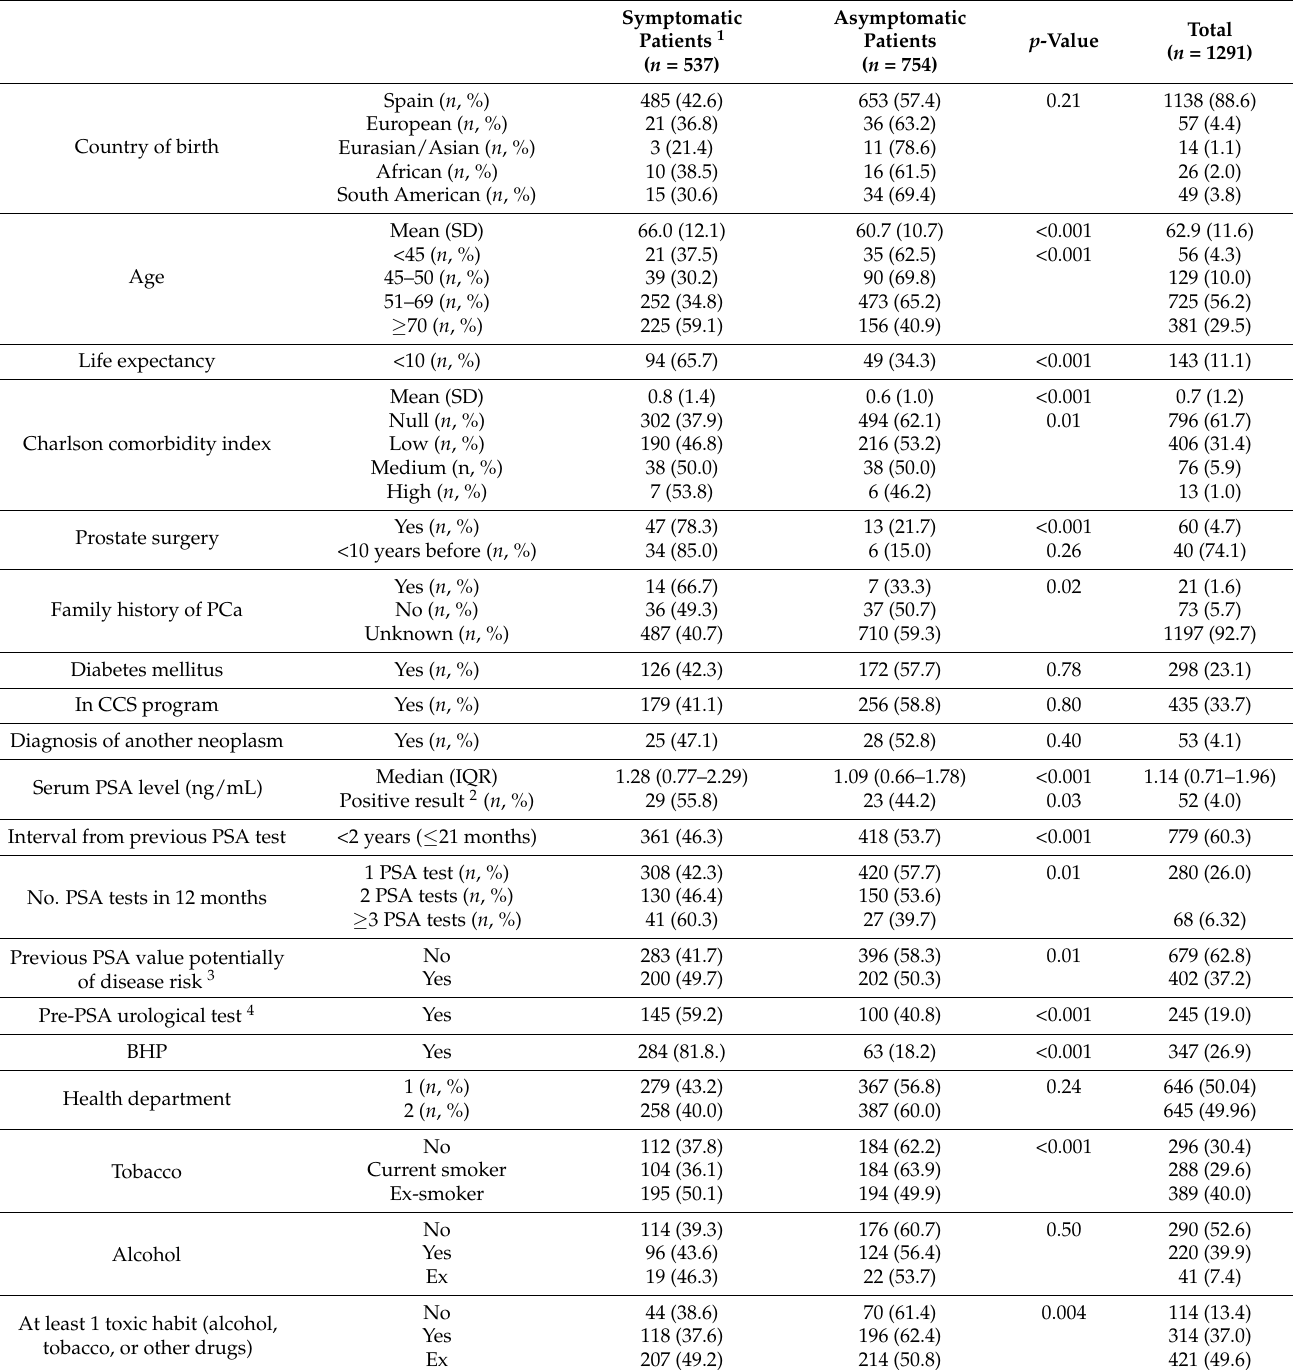
Table 1. Description of the study